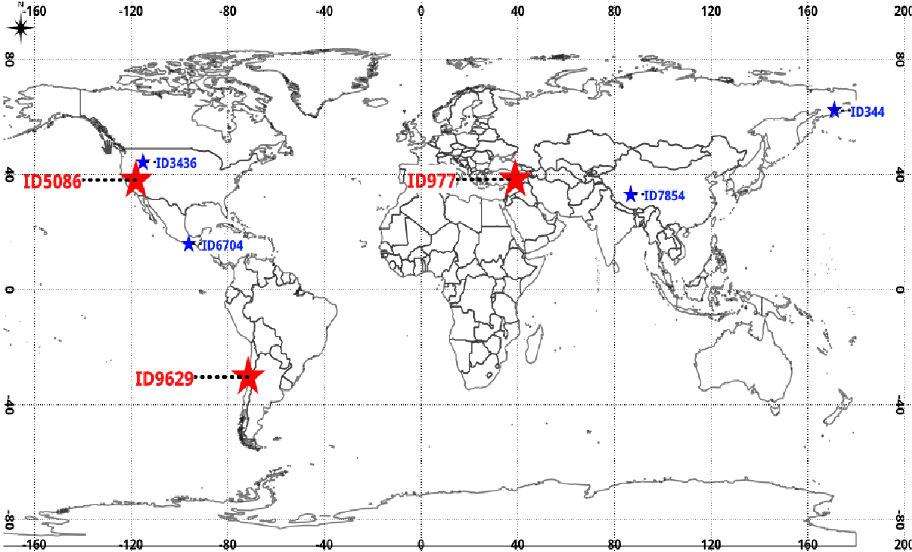
Figure 2. The map location M w > 6 earthquakes in 2020. Table 3. Details of earthquakes M w > 6 in 2020 [33] that are presented in Figure 4. (From a total of 1350 earthquakes analyzed).